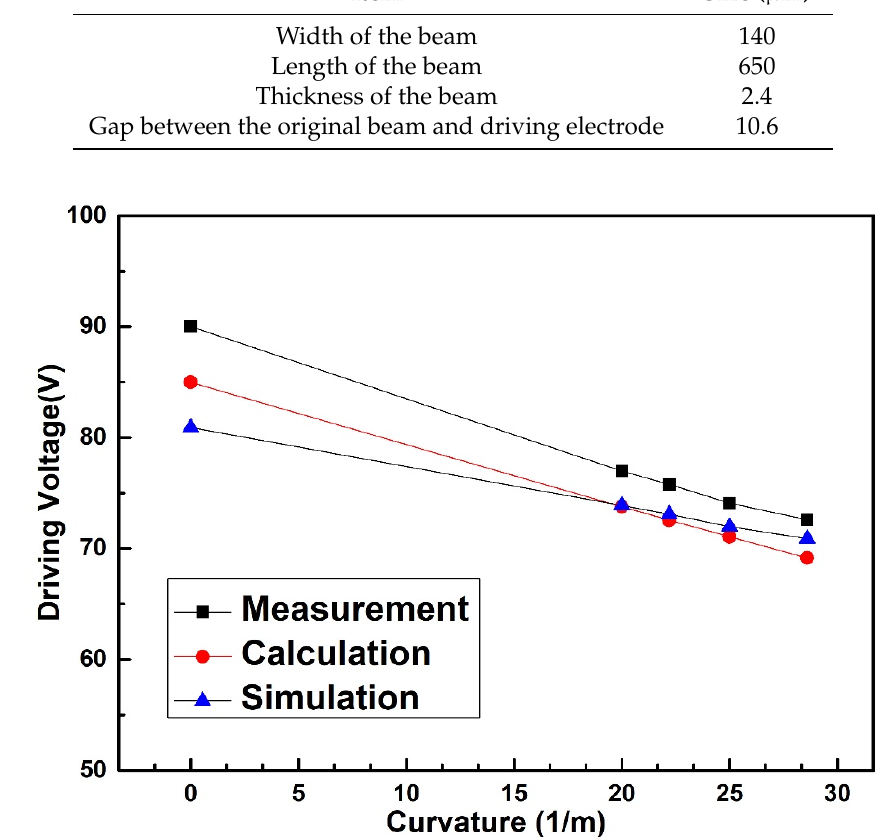
Figure 9. Measured driving voltage of the spring-like double-clamped beam switch with different bending curvatures.